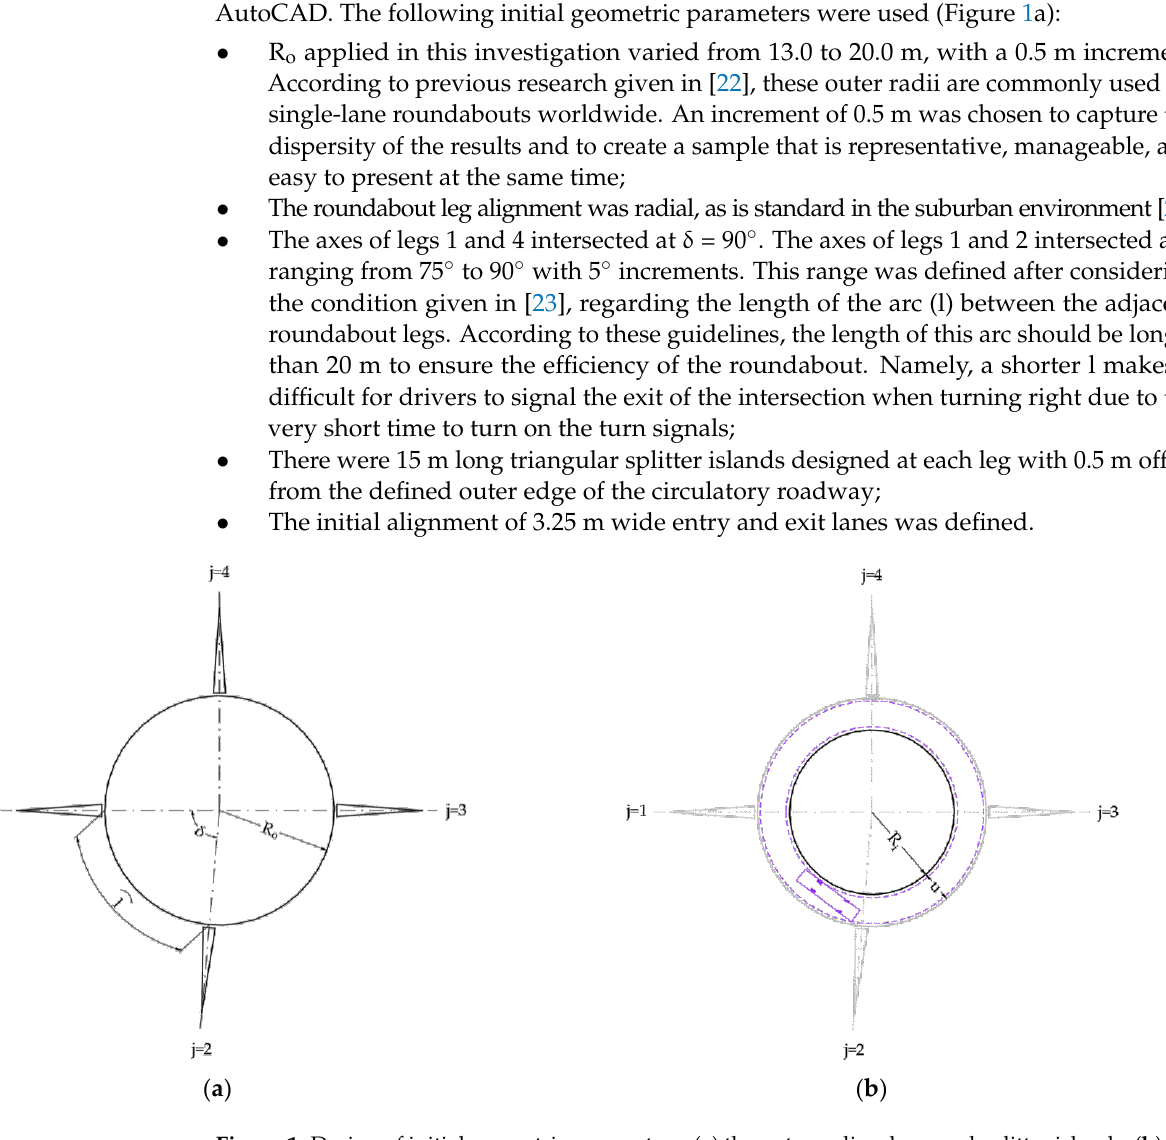
Figure 1. Design of initial geometric parameters: ( a ) the outer radius, legs, and splitter islands; ( b ) the central island radius and the circulatory roadway width defined based on the design vehicle swept path when driving in a full circle.